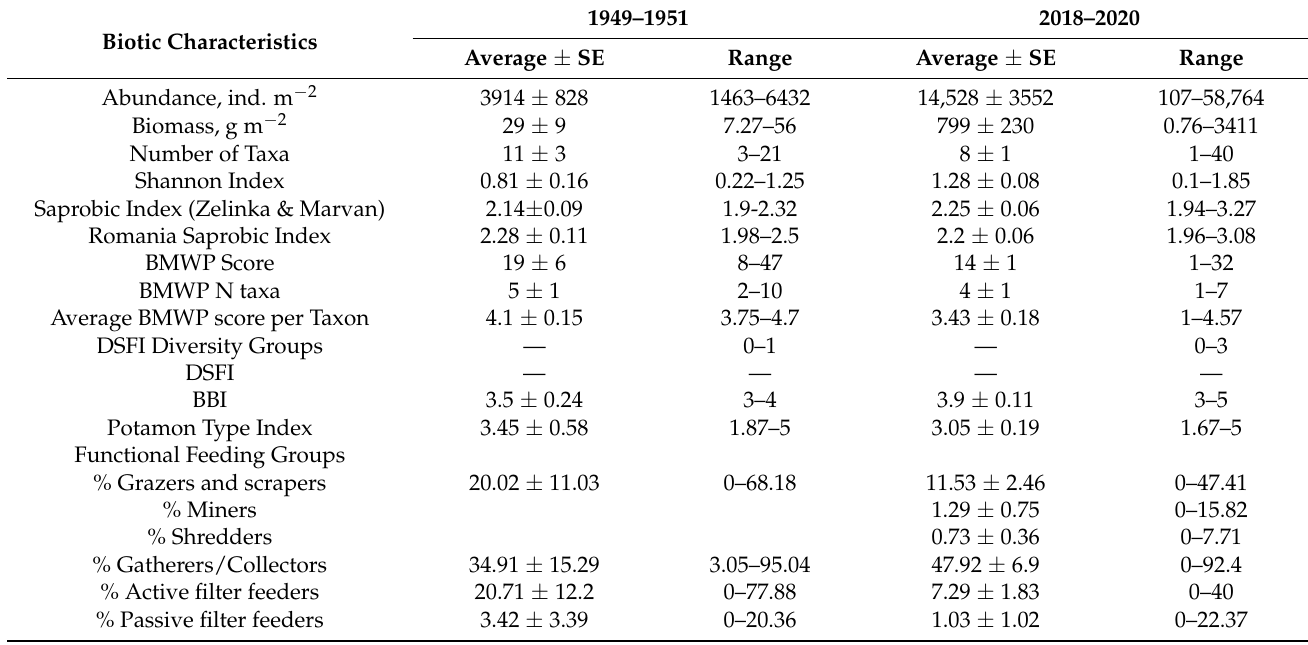
Table 3. Benthic community state of the Lower Dniester within natural flow [3,9] and modern periods, calculated using with Asterics